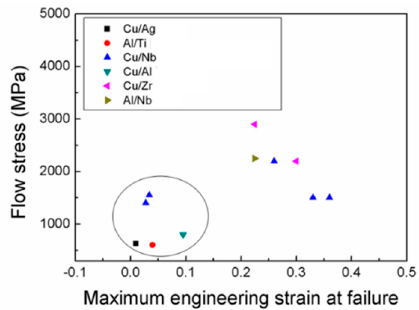
Figure 13. Flow stress versus maximum engineering strain at failure for various NMMFs with equal layer thickness. Circle indicates tensile data; remaining data are from micropillar compression tests. For all the cases, the individual layer thickness h is smaller than 100 nm.